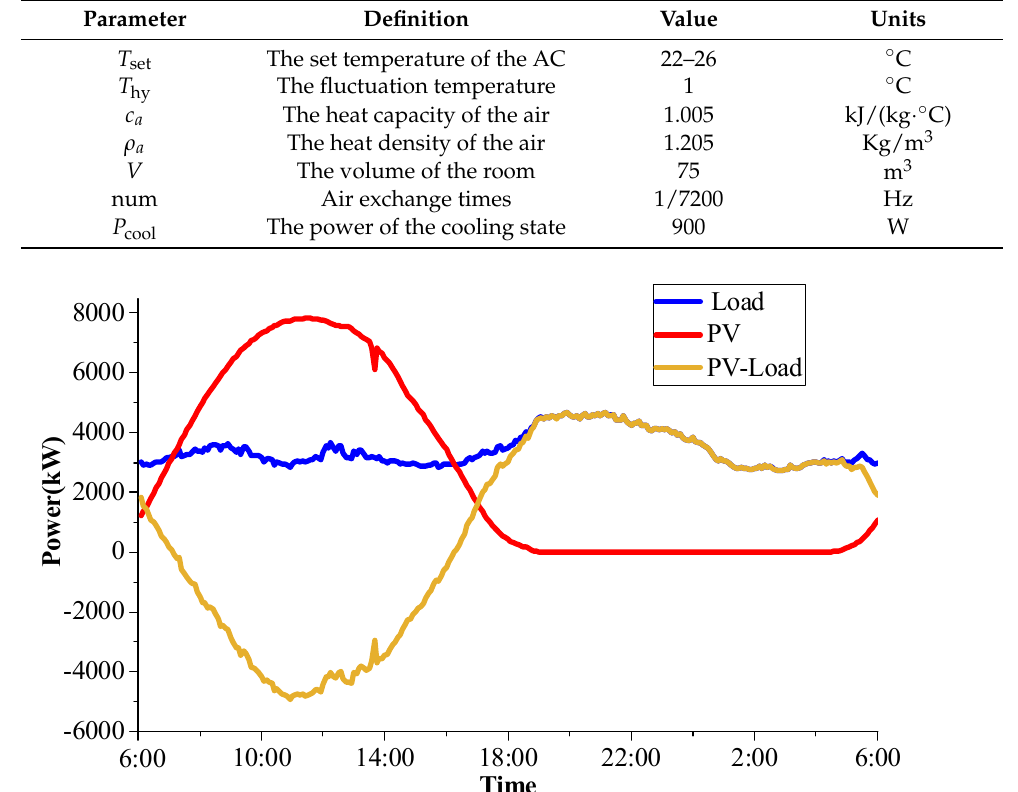
( b ) Figure 9. The voltages curves of nodes without any voltage optimization: ( a ) over-voltage problem; ( b ) under-voltage problem.